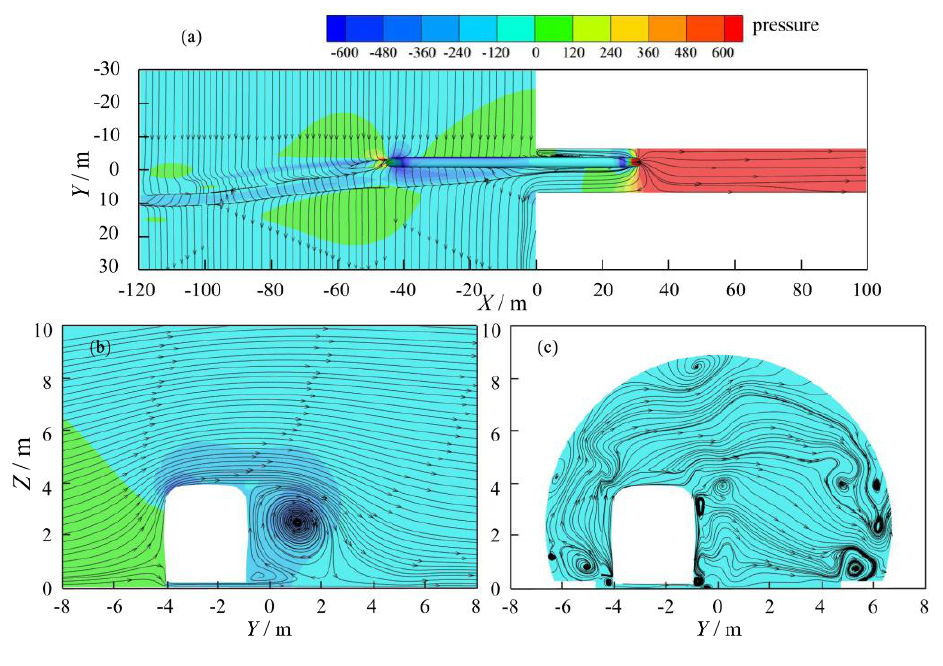
Figure 14. Pressure and flow distribution for train speed = 250 km/h, crosswind velocity = 15 m/s, ( a ) z = 1.55 m from top of rail, ( b ) 10 m outside tunnel entrance, and ( c ) 10 m inside tunnel entrance.